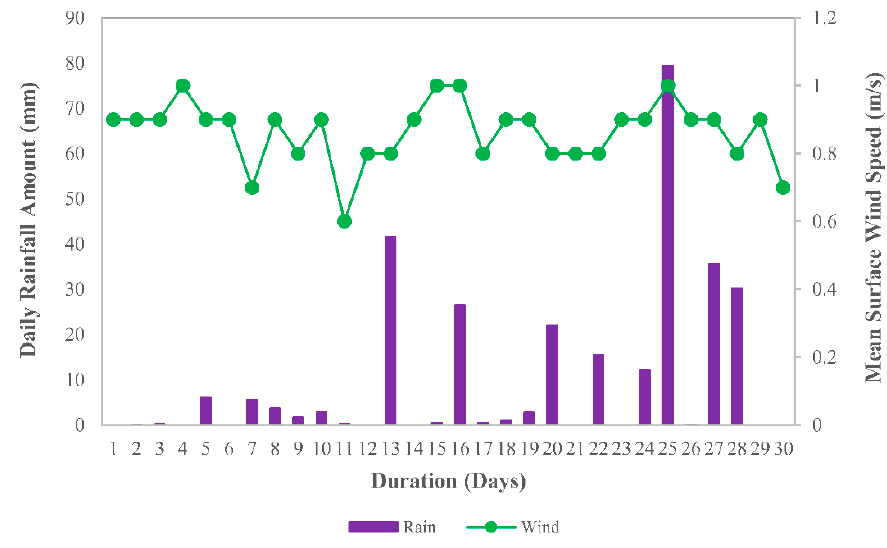
Figure 9. Daily rainfall amount and mean surface wind speed in April 2022.